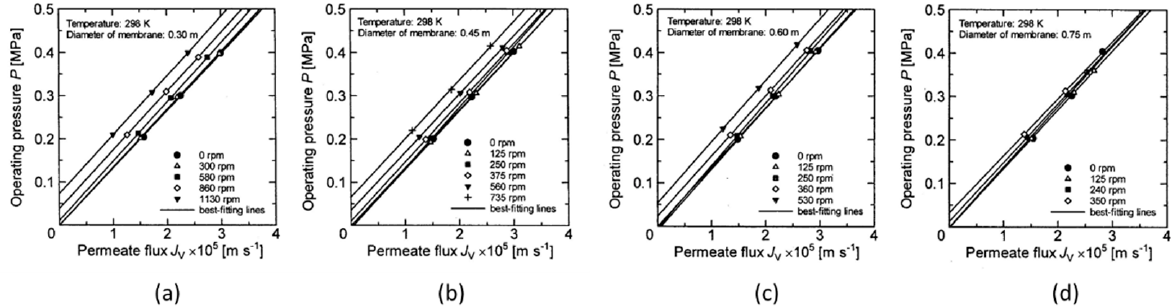
Figure 3. Relationship between the operating pressure and permeate water flux. ( a ) disk diameter 0.30 m ( b ) 0.45 m ( c ) 0.60 m ( d ) 0.75 m.